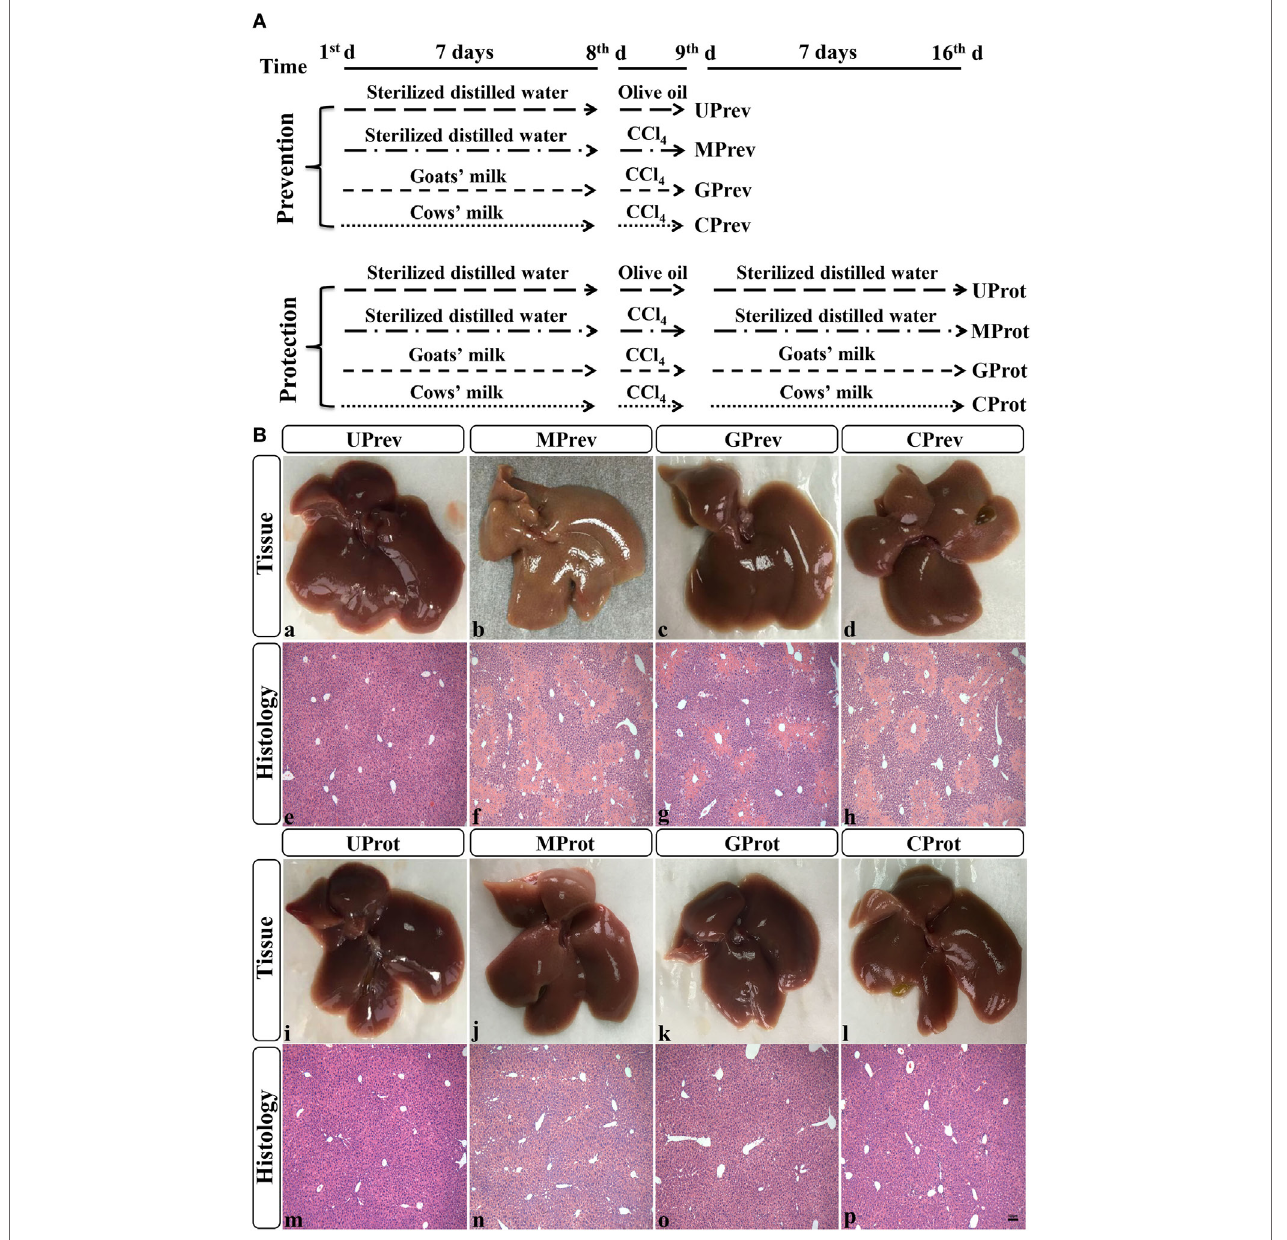
FigUre 1 | Experimental design (a) and histological analysis of livers from the eight different treatment groups of mice (see Figure 1a ) (B) (1). Liver samples taken 1 day after administration of CCl 4 (to determine preventive effects of milk consumption on induced liver injury) from untreated control mice UPrev (a), model mice MPrev (b), mice receiving goats’ milk GPrev (c), and mice receiving cows’ milk CPrev (d) and 8 days after administration of CCl 4 (to determine protective effects of continued milk consumption on induced liver injury) from untreated control mice UProt (i), model mice MProt (j), mice receiving goats’ milk GProt (k), and mice receiving cows’ milk CProt (l) (2). Liver histology [hematoxylin and eosin (H&E)] of UPrev (e), MPrev (f), GPrev (g), CPrev (h), UProt (m), MProt (n), GProt (o), and CProt (p) mice. Scale bar: 100 µm for e–h and